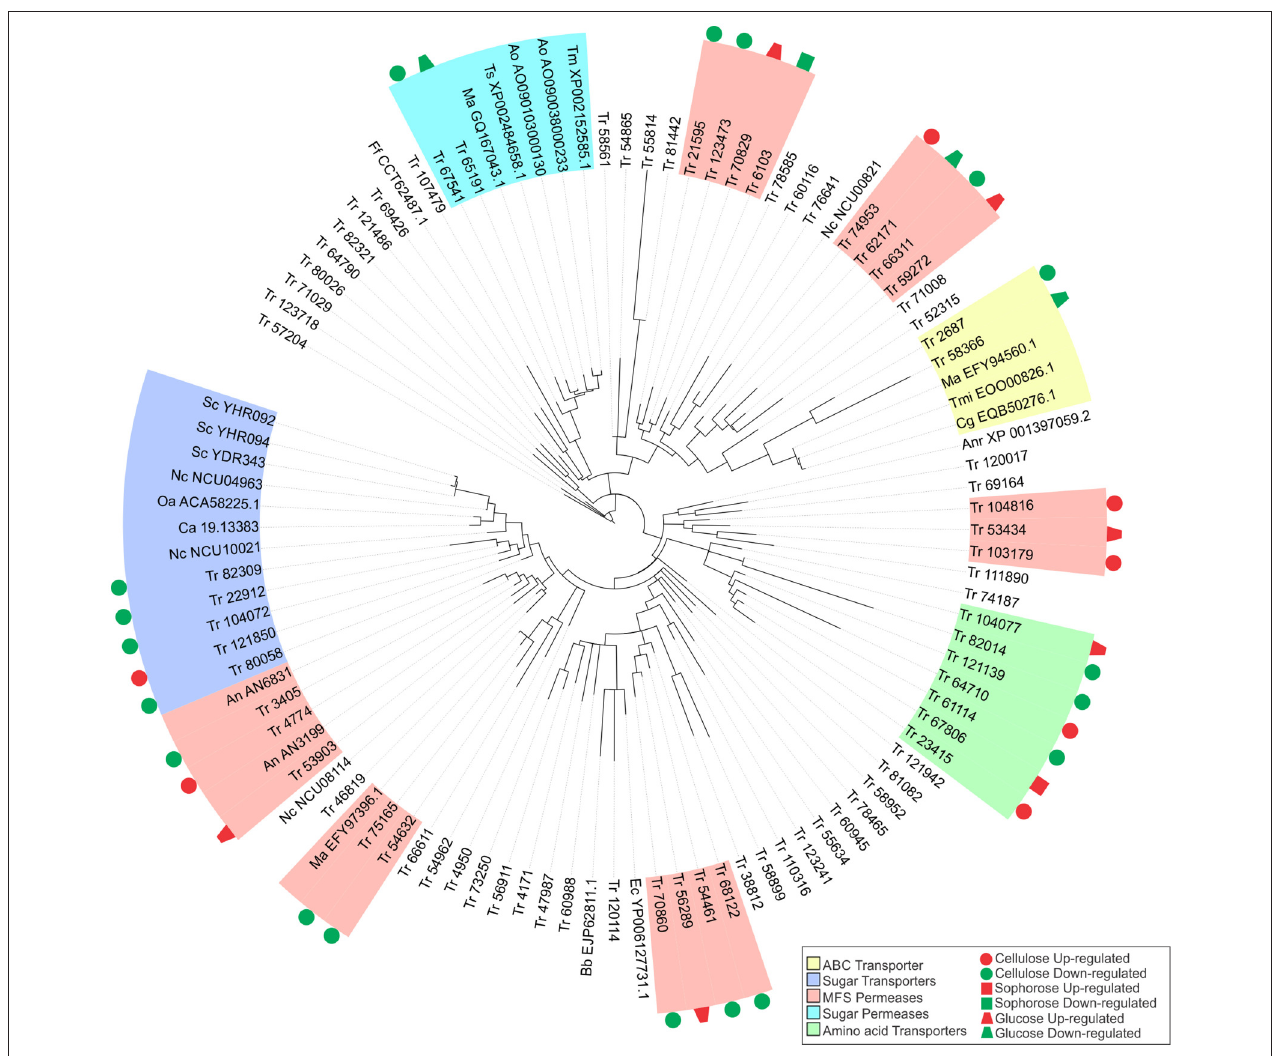
FIGURE 5 | Maximum-likelihood phylogenetic tree of transporters genes identified exclusively in the conditions studied. The radial tree was generated using iTOL ( Letunic and Bork, 2007,